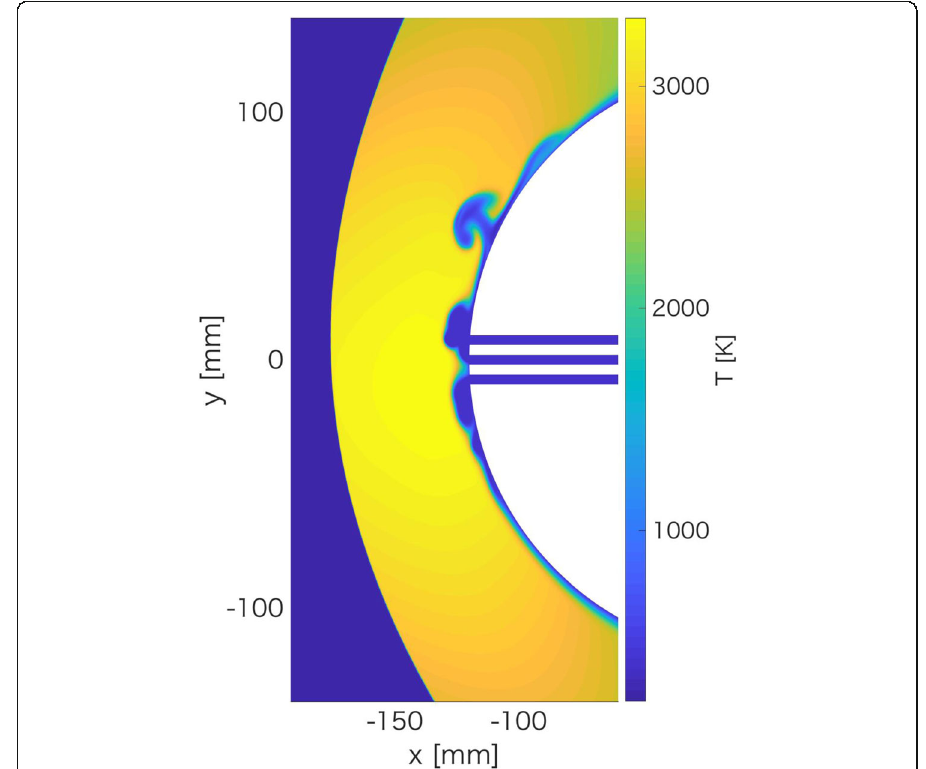
Fig. 13 A snapshot of the temperature field (Case-C, Model-2 Ω = 5°, 7.6 × 10 5